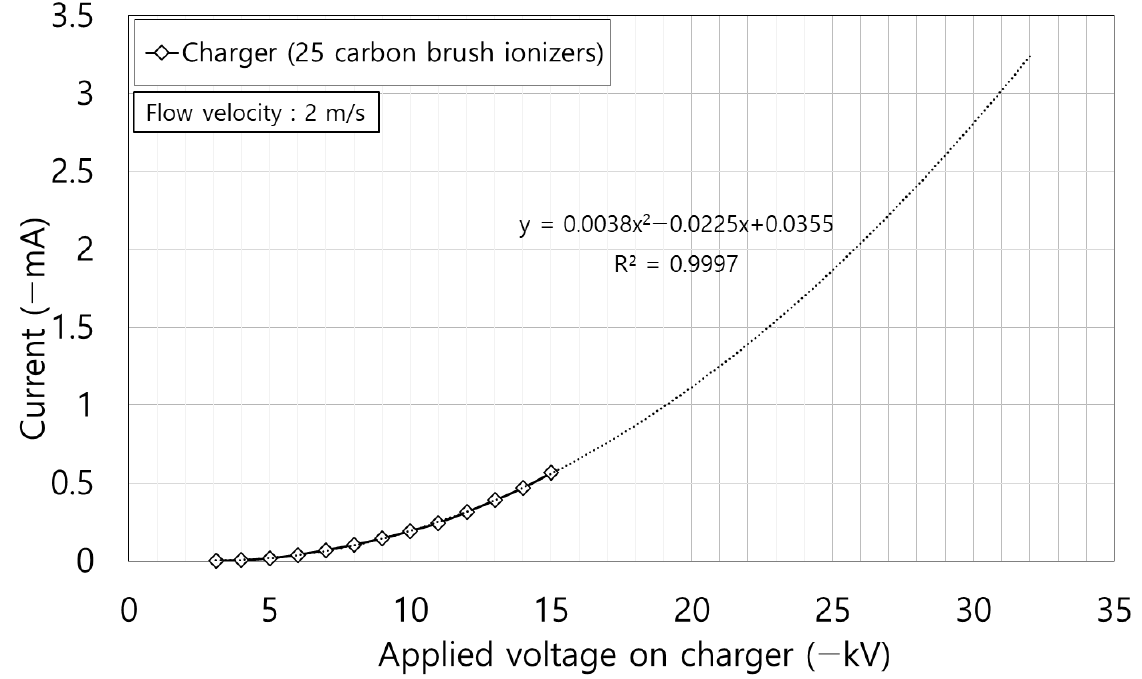
Figure 4. Corona discharge current according to the applied voltage of the charger.